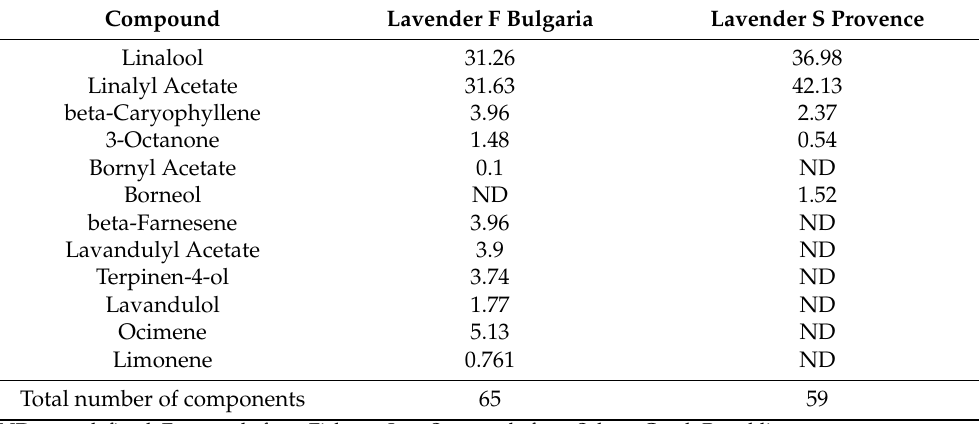
Table 1. Chemical composition of Lavandula angustifolia according to the manufacturer.